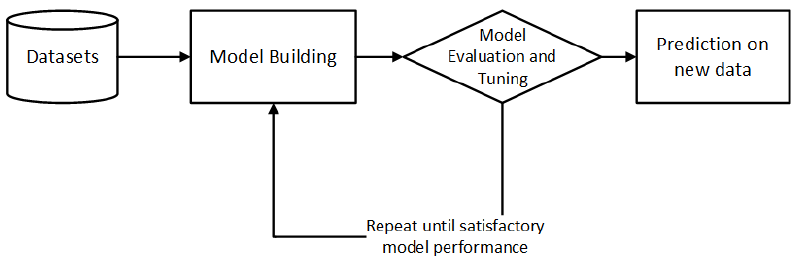
Figure 3. The basic workflow of ML systems is shown. The datasets are loaded into the ML algorithm, which learns the appropriate parameters for the task. The model evaluation and tuning process may involve modifying the learned model parameters and hyperparameter tweaking until an acceptable accuracy level is achieved. The model is then tested on new data to verify its